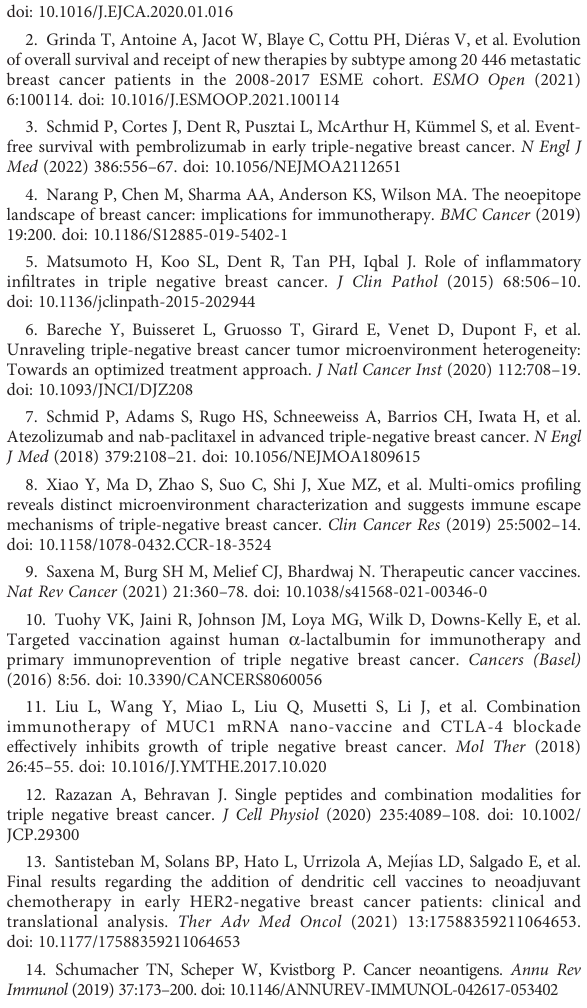
SUPPLEMENTARY TABLE 1 List of identi fi ed mutations. SUPPLEMENTARY TABLE 2 Mutations with con fi rmed expression by RNAseq. SUPPLEMENTARY TABLE 3 HLA class I alleles expressed by patients. SUPPLEMENTARY TABLE 4 Prediction of binding to HLA class I molecules of mutated and wild type peptides. SUPPLEMENTARY TABLE 5 Prediction of binding to HLA class II molecules of mutated and wild type